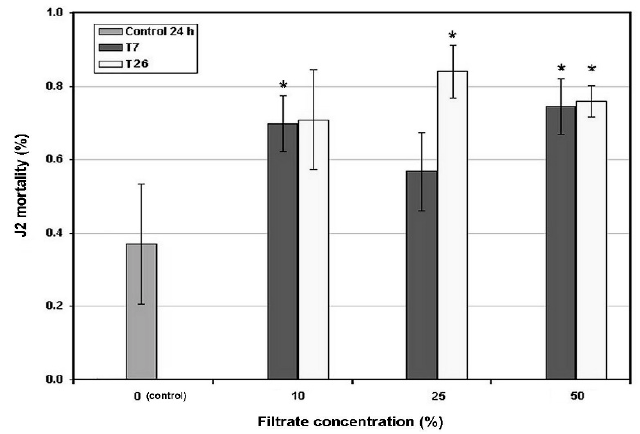
Figure 2. The in vitro effect of the culture filtrates of Trichoderma afroharzianum isolate T7 and T. harzianum isolate T26 on Meloidogyne incognita second stage juveniles (J2), after 24 h exposure at 26 °C, at different concentrations. The control was a 50% dilution of the culture medium used for fungal growth, without the filtrate addition. Bars show the means ± SD. Asterisks show the means significantly different from the control (Student’s t test, p < 0.05).